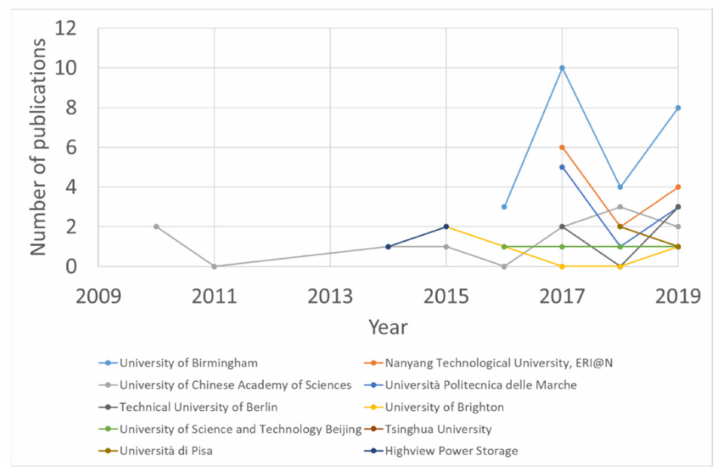
Figure 7. Trend of publications of the top 10 institutions between 2009 and